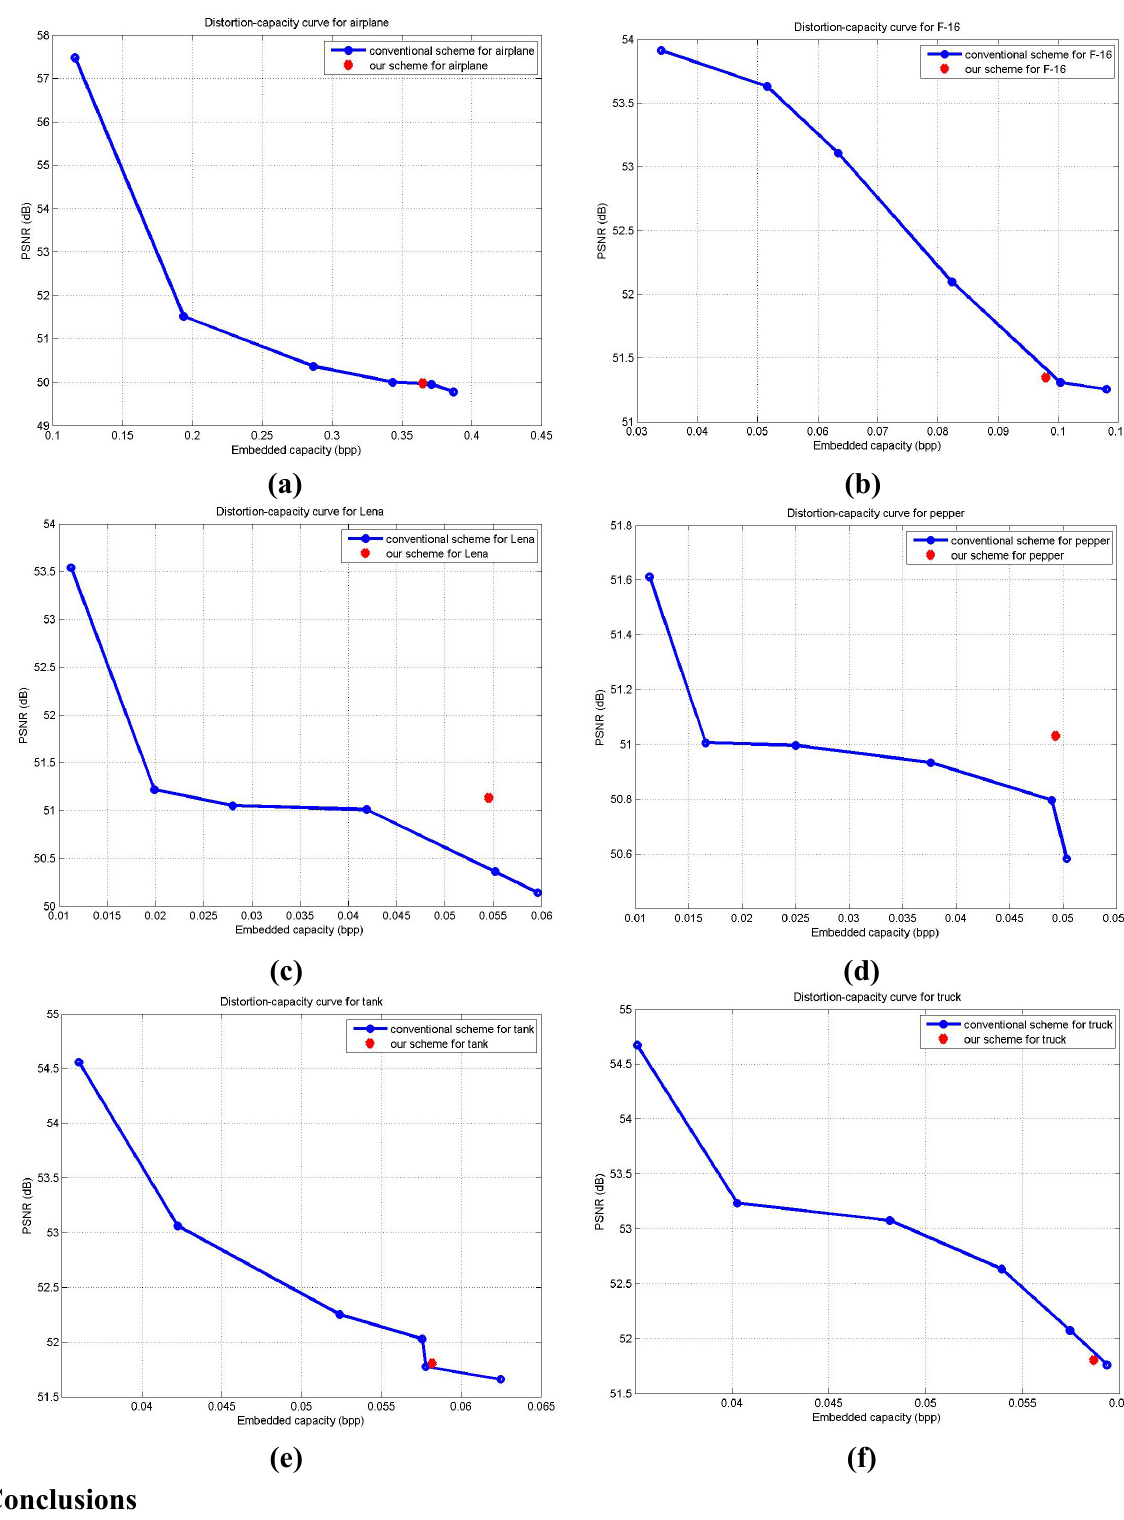
Figure 7. Distortion-capacity curves for the test images. Blue curves present the distortion-capacity curve with the modified scheme in [8], and the red dot denotes the result with our scheme. (a) airplane. (b) F-16. (c) Lena. (d) pepper. (e) tank. (f)